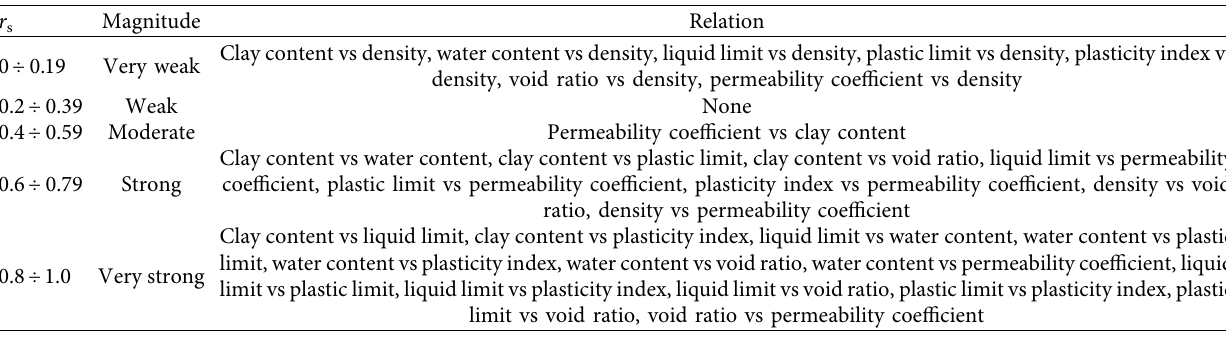
Figure 2: Pearson’s correlation coefficient of input-output relations. Table 2: Pearson’s rank correlation